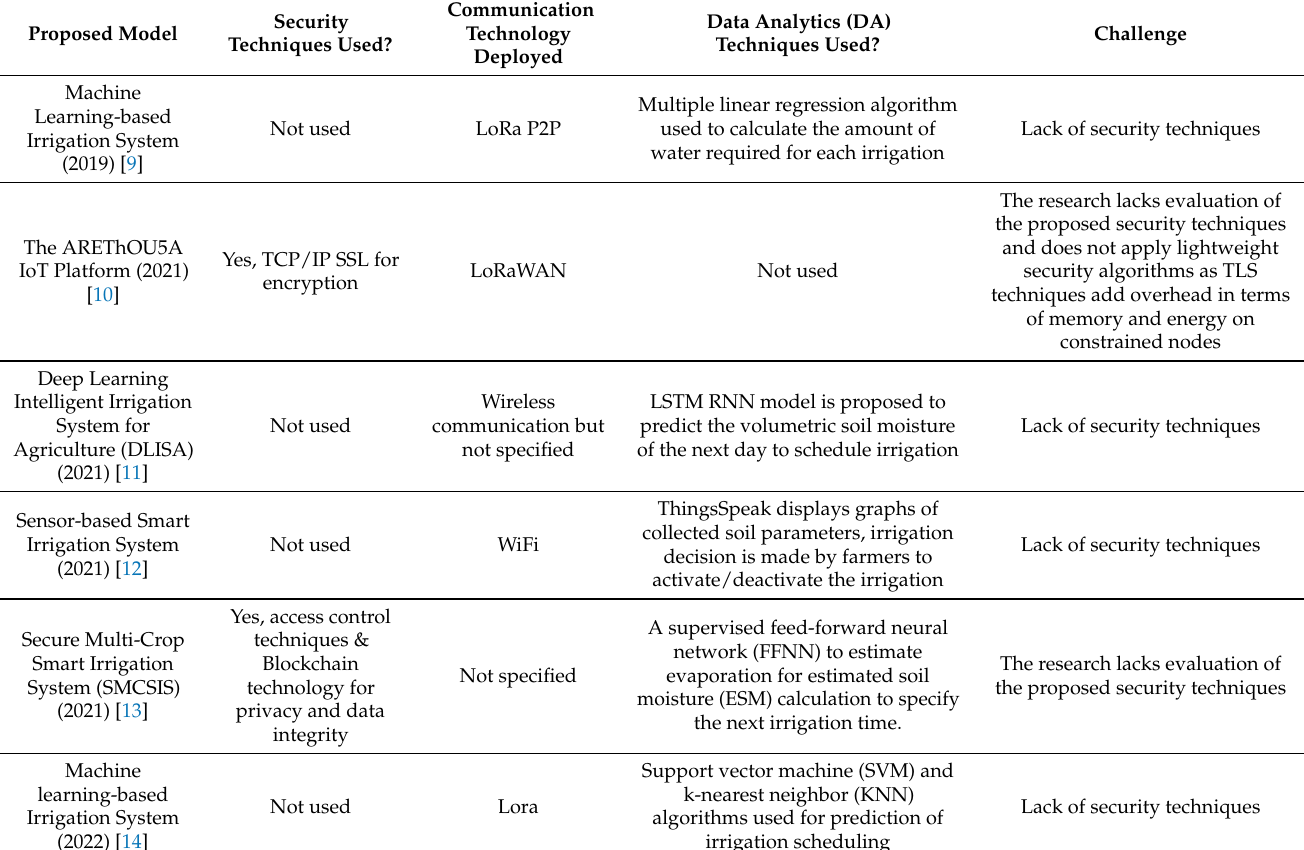
Table 1. Literature review of recently proposed IoT-based precision irrigation